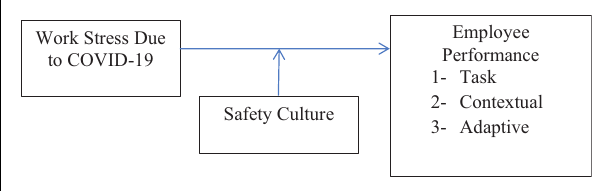
FIGURE 1 | Proposed research